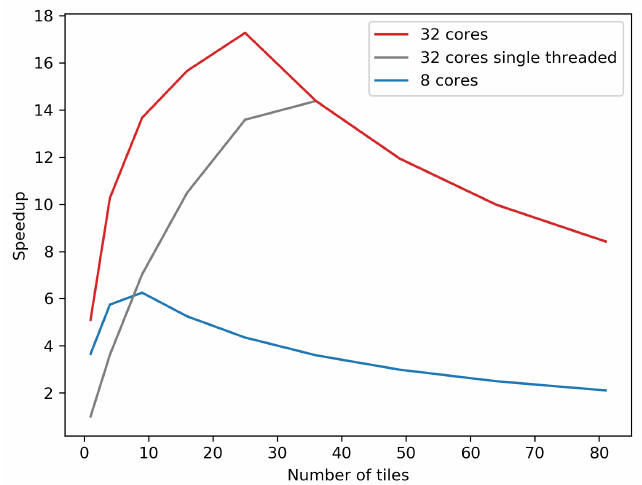
Figure 7. Speedup obtained with processing on a single virtual machine with 8 (blue) and 32 (red) cores. Speedup obtained via tiling without multi-threading is shown in gray (32